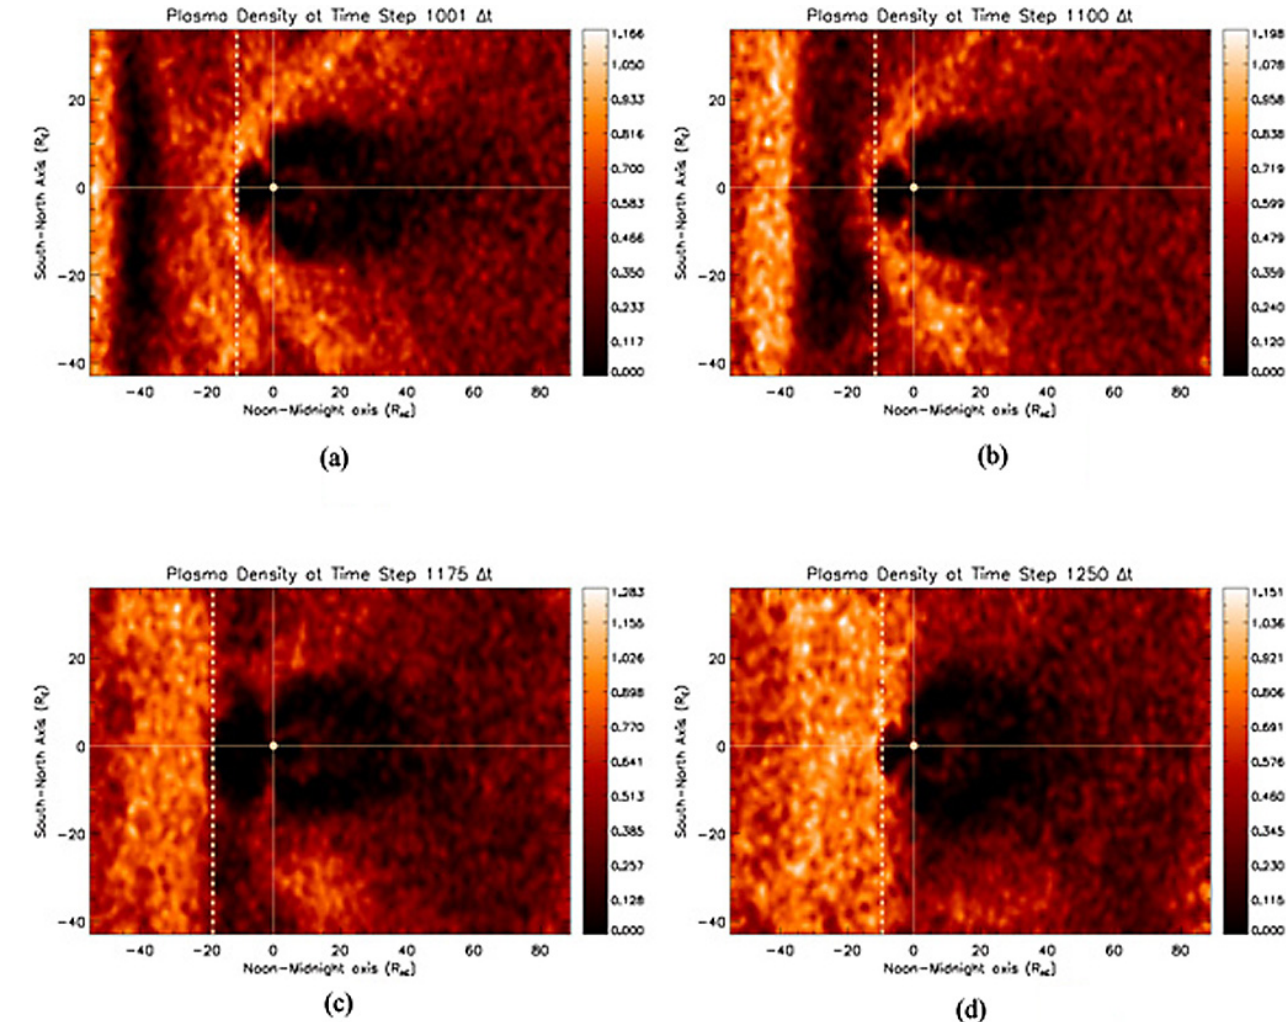
Fig. 3. Time sequence of the response of Earth’s magnetosphere to a depression in the incident SW flow for B z > 0. Plasma density is shown in panels (a) , (b) , (c) and (d) , taken at 1001, 1100, 1175 and 1250 1t respectively. All plots are shown in the x-z plane and centered on Earth’s position at [0, 0, 0] R E corresponding to [60, 52, 53] R E in the simulation